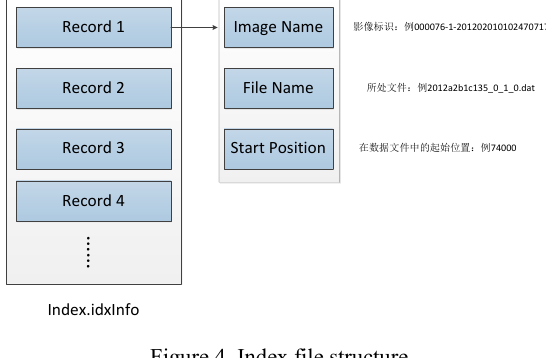
Figure 4. Index file